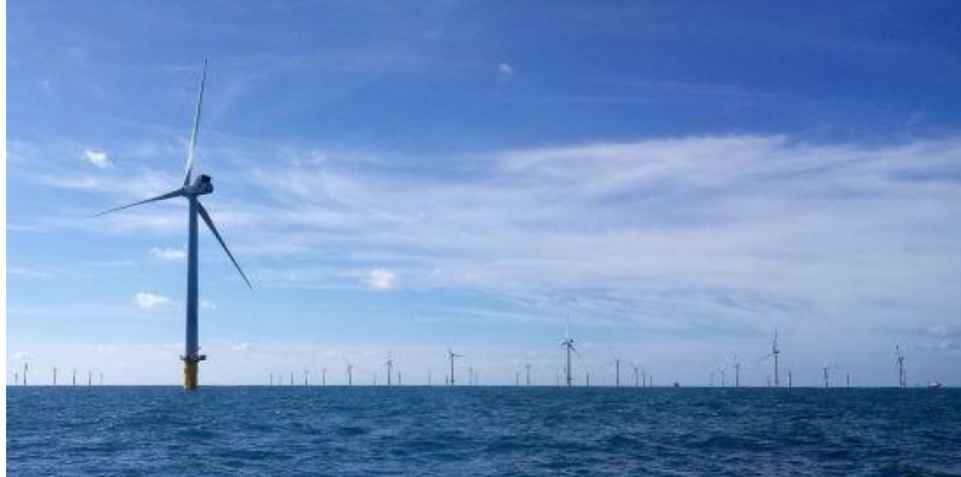
Fig. 25. Rampion Wind Farm Brighton, UK.